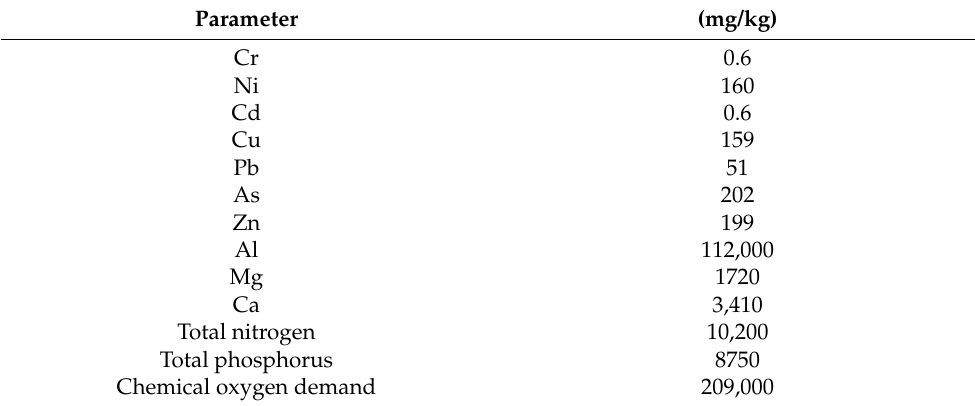
Table 1. Composition of potentially toxic elements and key chemical constituents of waterworks sludge used in this study.